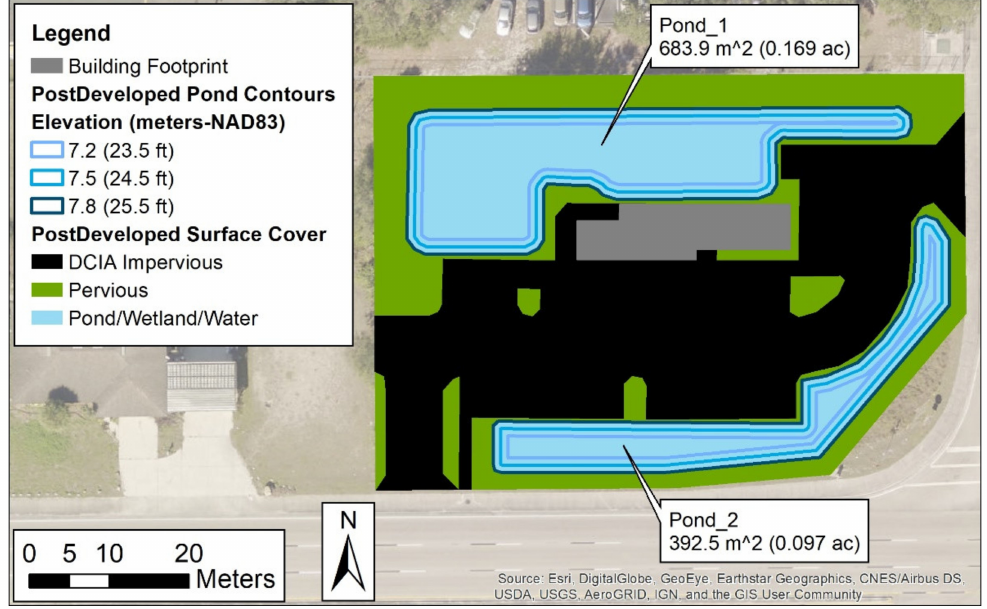
Figure 6. Post-development pond contours and surface